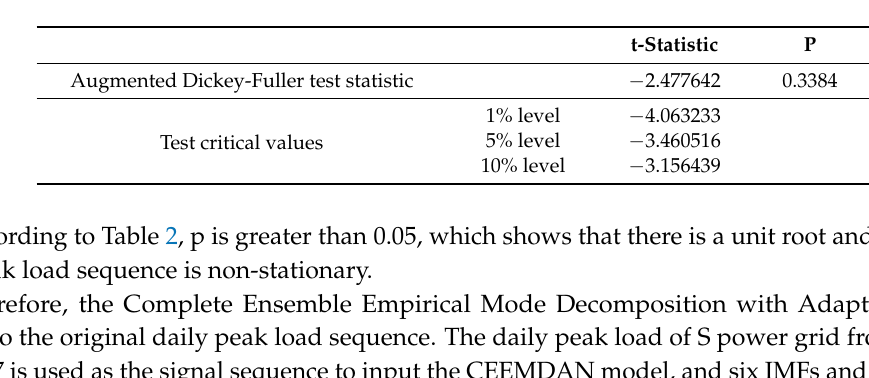
Table 2. The unit root test result.